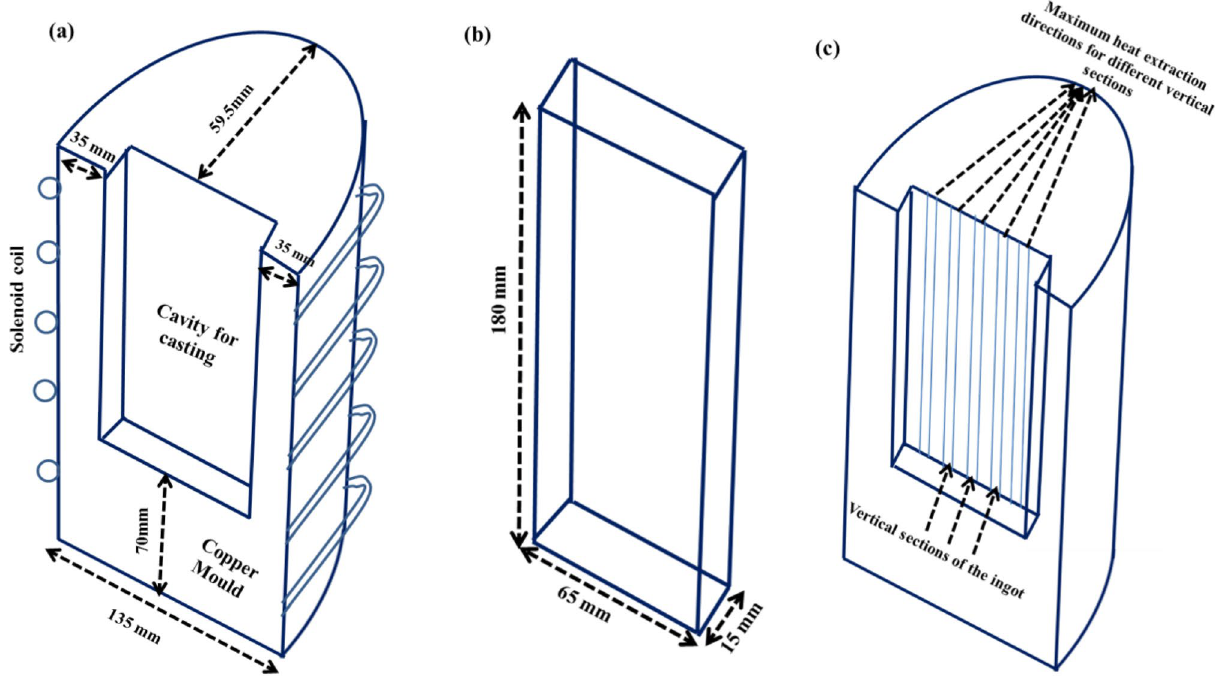
Figure 1. Schematic representation of the ( a ) axisymmetric view of the copper mould; ( b ) slab ingot cast within the copper mould; ( c ) maximum heat extraction direction for different sections of the